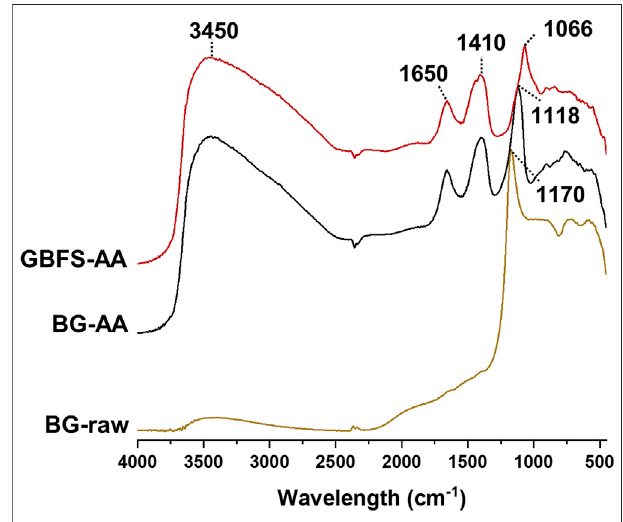
FIGURE 5 | DRIFT FTIR spectra for the raw BG and the alkali activated